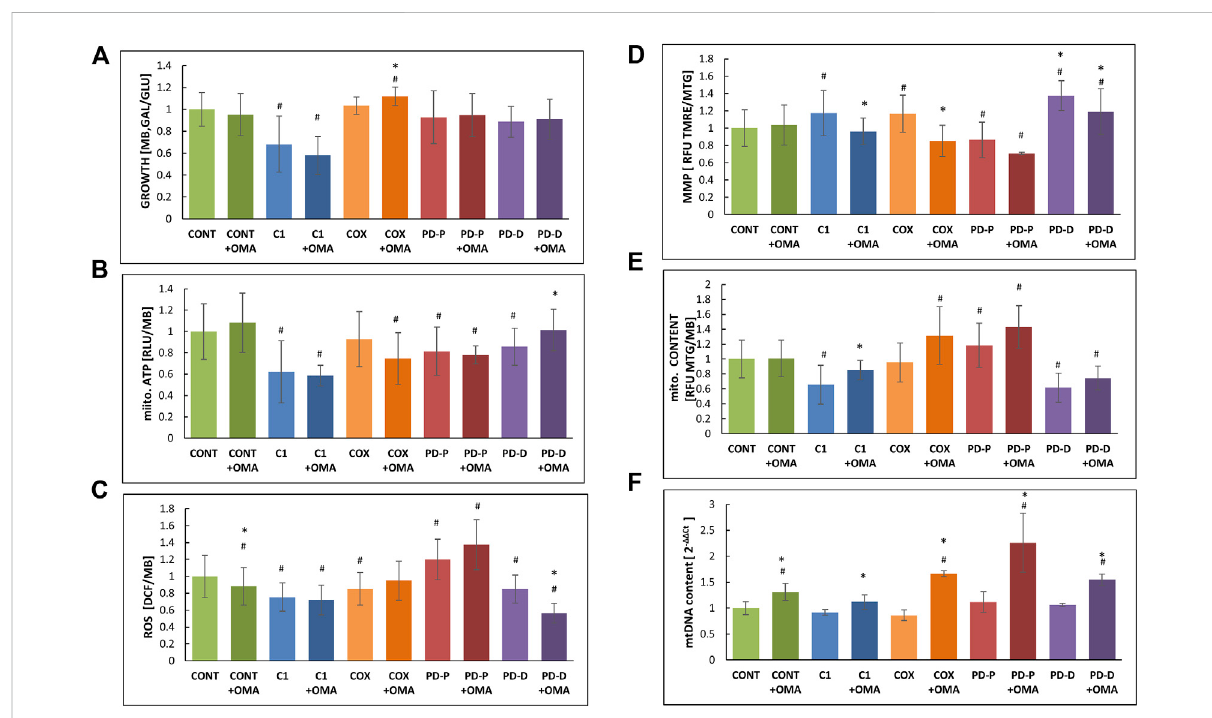
Effect of omaveloxolone on cell growth, ATP production, ROS production, MMP, and mitochondrial and mtDNA content. An equal amount of control (CONT) cells with mitochondrial CI (C1) or COX (COX) de fi ciency or PD with mutated PRKN (PD-P) or mutated DJ-1 (PD-D) was seeded in microtiter wells, cultivated in the presence or absence of 50 nM omaveloxolone (OMA) for 72 h in permissive (GLU) or restrictive (GAL) medium where after the following parameters were measured; (A) growth ratio GAL vs. GLU measured by methylene blue staining (MB); (B) mitochondrial ATP production measured by luciferin – luciferase (RLU) normalized to MB; (C) ROS production measured by DCF and normalized to MB; (D) mitochondrial membrane potential (MMP) was calculated with the ratio of TMRE to MTG relative fl uorescence units (RFU); (E) mitochondrial content was measured by MTG, RFU and normalized to MB. (F) mtDNA content was measured by qPCR of the mitochondrial MT-TL1 gene and normalized to the nuclear β 2M. Results are presented as mean ± SD relative to controls ( n = 3). # p < 0.05 compared to untreated control mean, * < 0.05 compared to the individual cell without